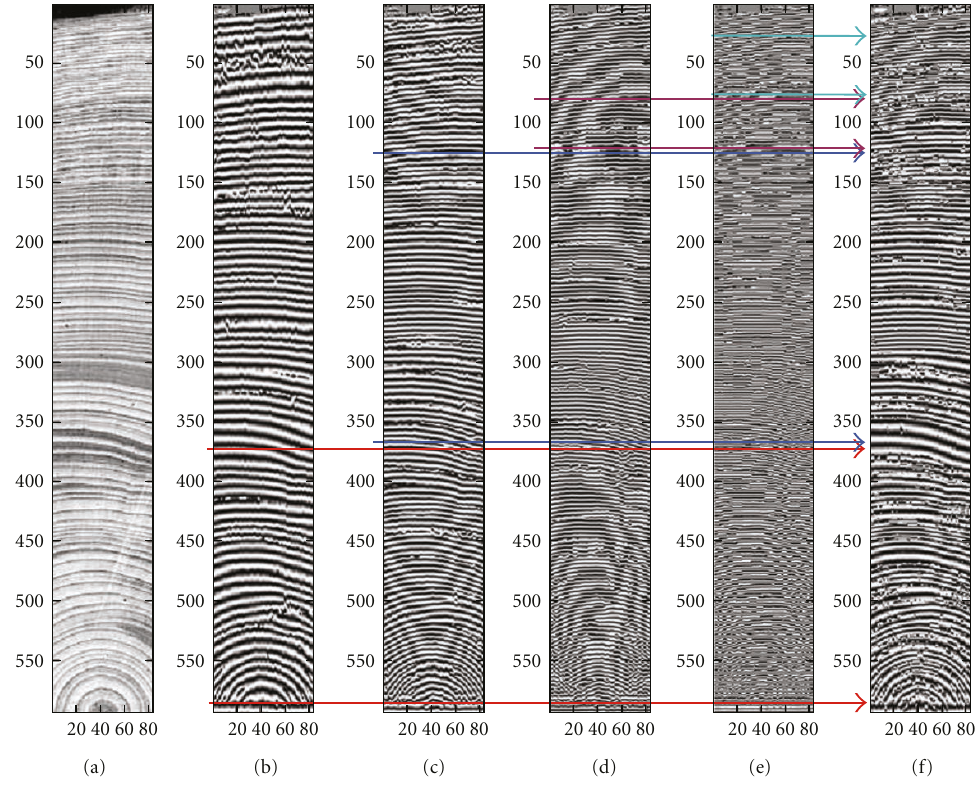
Figure 6: Dominant component analysis example (spruce sample). Left to right: original image, FM output using low frequency filter, FM using medium frequency filter, FM using high frequency filter, FM using very high frequency filter and dominant FM output. Image courtesy: Henry Grissino-Mayer (http://web.utk.edu/ ∼ grissino/Site/gallery/galleries/Tree%20Ring%20Gallery%201/images/